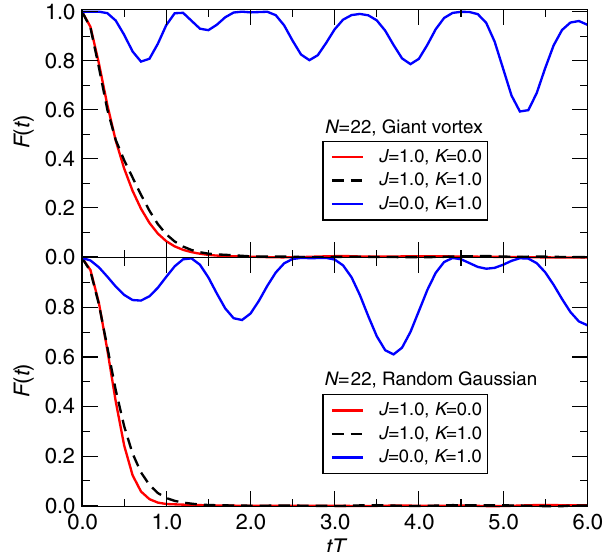
FIG. 8. Out-of-time-order correlators for our giant vortex system (top) and random Gaussian couplings (bottom). Nonzero temperature T ¼ 1 has been taken and other parameters as in Fig. 4. Correlators are displayed for a single disorder realization (unaveraged), but different realizations give very similar results for all interacting cases. Detailed shape of the oscillations apparent in the J ¼ 0 curves depends sensitively on the specific disorder realization, but all realizations show qualitatively similar